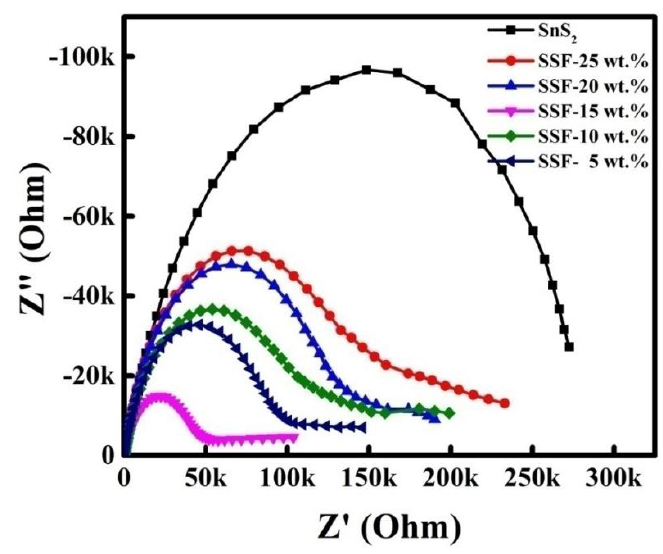
Figure 5. Electrochemical impedance spectroscopy (EIS) spectra of SnS 2 and different concentrations of SSF-X nanocomposites (X = 5, 10, 15, 20, and 25 wt %).